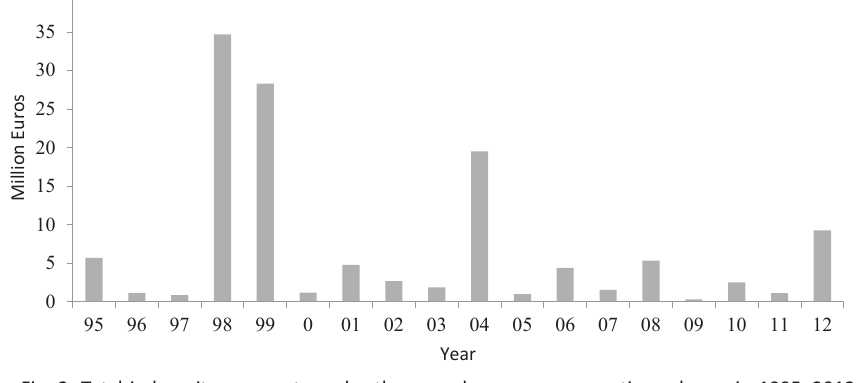
Fig. 2. Total indemnity payments under the crop damage compensation scheme in 1995 – 2012 (millions of Euros) Table 3. Average number of hectares lost (total and partial loss hectares per 1,000 cultivated hectares) and indemnity payments per year for barley, oats, winter and spring wheat and rye in the CDC scheme (1995 – 2012) Total losses Partial losses Average hectares lost (SD) 1 % %